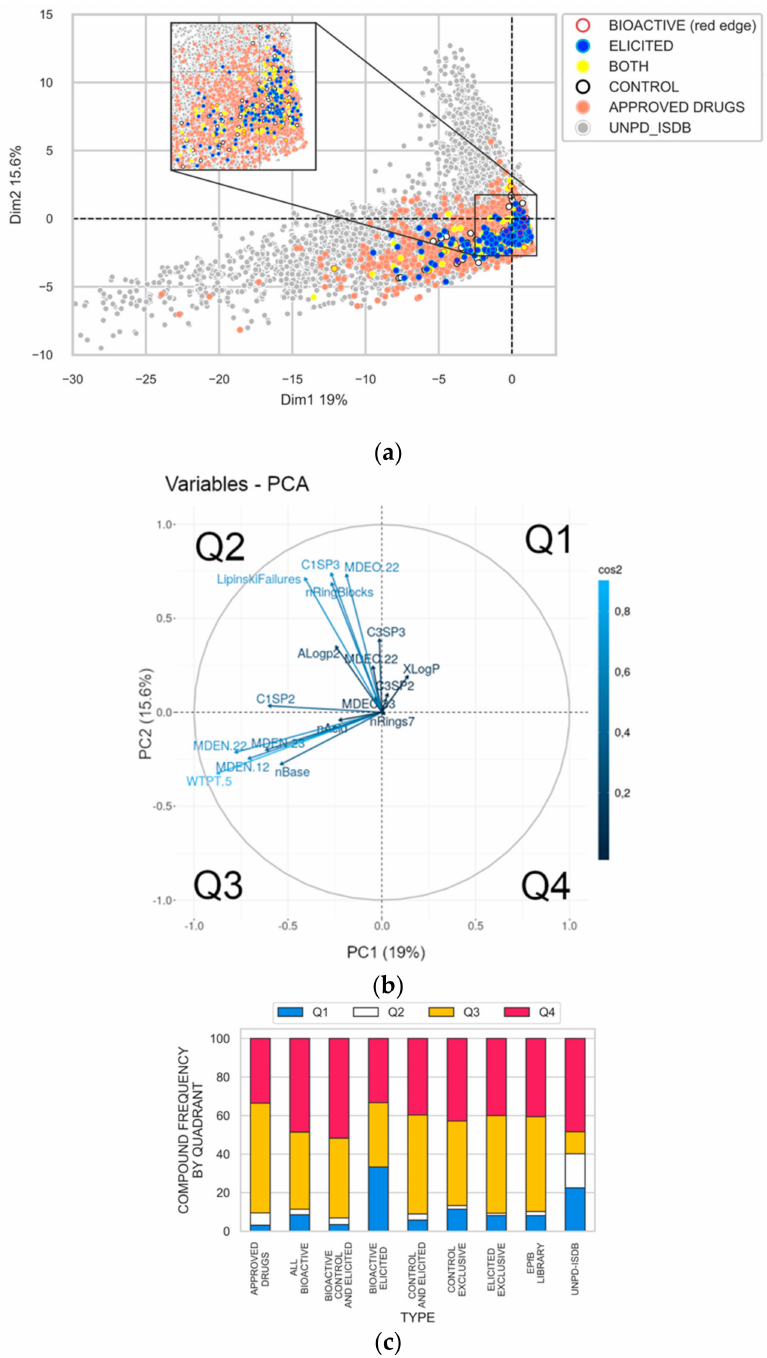
Figure 6. PCA based on molecular descriptors of compounds detected and identified in the EPfB library shows that the retrieved bacterial metabolites cover the chemical space of the approved drugs. ( a ) Chemical space coverage of identified compounds from consensus spectra exclusively detected in the following growth conditions: elicited (blue), controls (white) and both (yellow). Compounds found in the bioactive fractions are denoted by a red edge. For reference, compounds present in the UNPD-ISDB database ( n = 208,009 natural products) and the DrugBank (subset of approved drugs, n = 2078 drugs) were also used in the PCA analysis and are shown in grey and salmon, respectively. A zoomed view at the central region of the PCA is shown in the inset for better visualization. ( b ) The PC1 and PC2 axes that separate the four quadrants (Q1 to Q4) are shown in black dotted lines. The main variables of contributing molecular descriptors are shown and labeled. ( c ) Relative frequency of compounds found in each quadrant by chemical